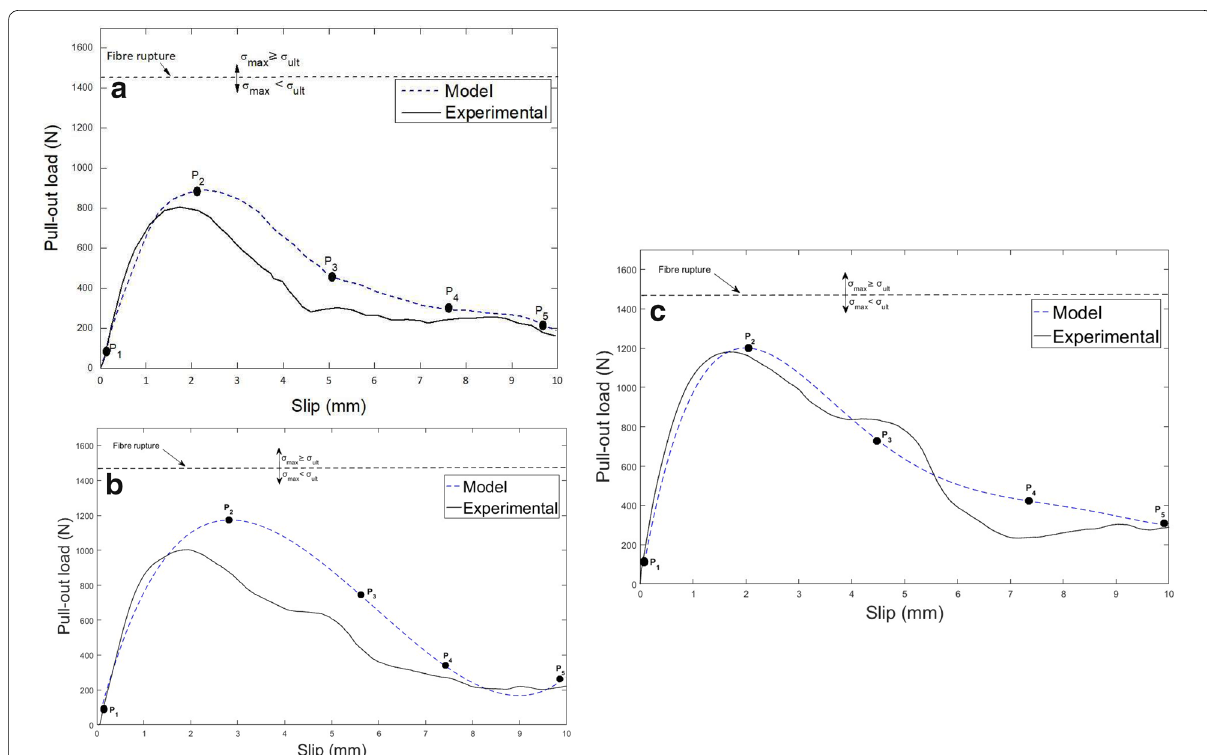
Fig. 19 Comparison of the predicted and experimentally measured pull-out curves for 5DH fibre. a NSC, b MSC and c HSC